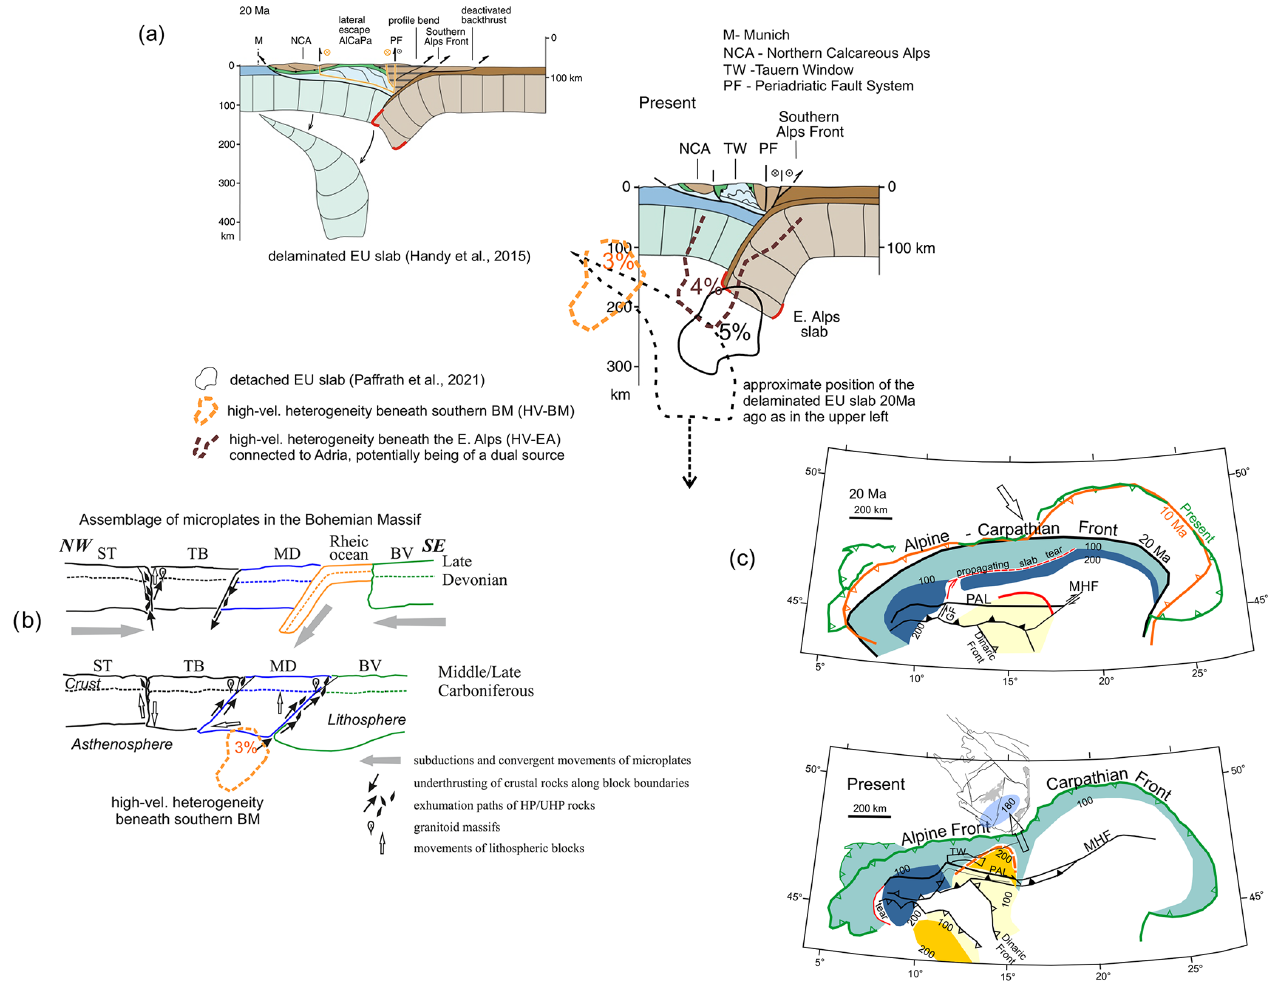
Figure 8. Interpretation of the slab at shallow depth beneath the Eastern Alps (HV-EA), its Adriatic vs. European provenance, and potential scenarios for the origin of the heterogeneity beneath the south-eastern Bohemian Massif (HV-BM). (a) Cartoons of the European slab (EU) delamination at 20Ma (upper left) and configuration of the Europe–Adria plate collision at present (lower right). Figure redrawn from Handy et al. (2015) (for the location of the profile see their Fig. 10) by overlaying the location of the high-velocity heterogeneities from the EASI- AA model in a cross section along 13.3 ◦ E (Fig. 3b) and the model of Paffrath et al. (2021); (b) a scenario considering closure of the Rheic ocean and collision of the Brunovistulian micro-plate with the Moldanubian part of the BM in a portion of a schematic cartoon by Babuška and Plomerová (2013), with a piece of remnant lithosphere image as the HV-BM in this paper; (c) a scenario related to fragmentation of the Alpine and Carpathian front. Differences in the roll-back subductions of the Alps and the Carpathians (e.g. Royden and Burchfiel, 1989; Royden, 1993), northward push of Adria, and European slab delamination beneath the Eastern Alps (Handy et al., 2015) could have formed complex flows in the asthenosphere, which might “transport” lithosphere fragments toward the north-west. For more details see the main text. The high-velocity contours are drawn according to Fig.